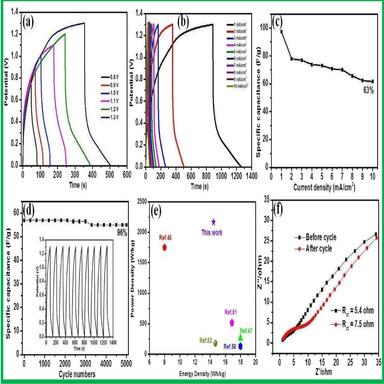
(a) Galvanostatic charge discharge cycles of optimized asymmetric device measured at different working potential windows at a current density of 2 mA cm2 (b) Galvanostatic charge discharge cycles at different current densities 1e10 mA cm2 (c) Function of specific capacitance at different current densities of asymmetric device (d) cycling stability of asymmetric device measured at a current density of 5 mA cm2 (e) Ragone plot of asymmetric device (f) Nyquist plot of asymmetric device before and after 5000 cy